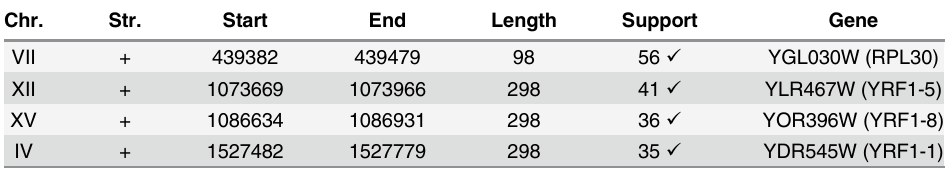
IV The unspliced transcript appears to constitute the major isoform. Splicing of the listed introns disrupts the reading